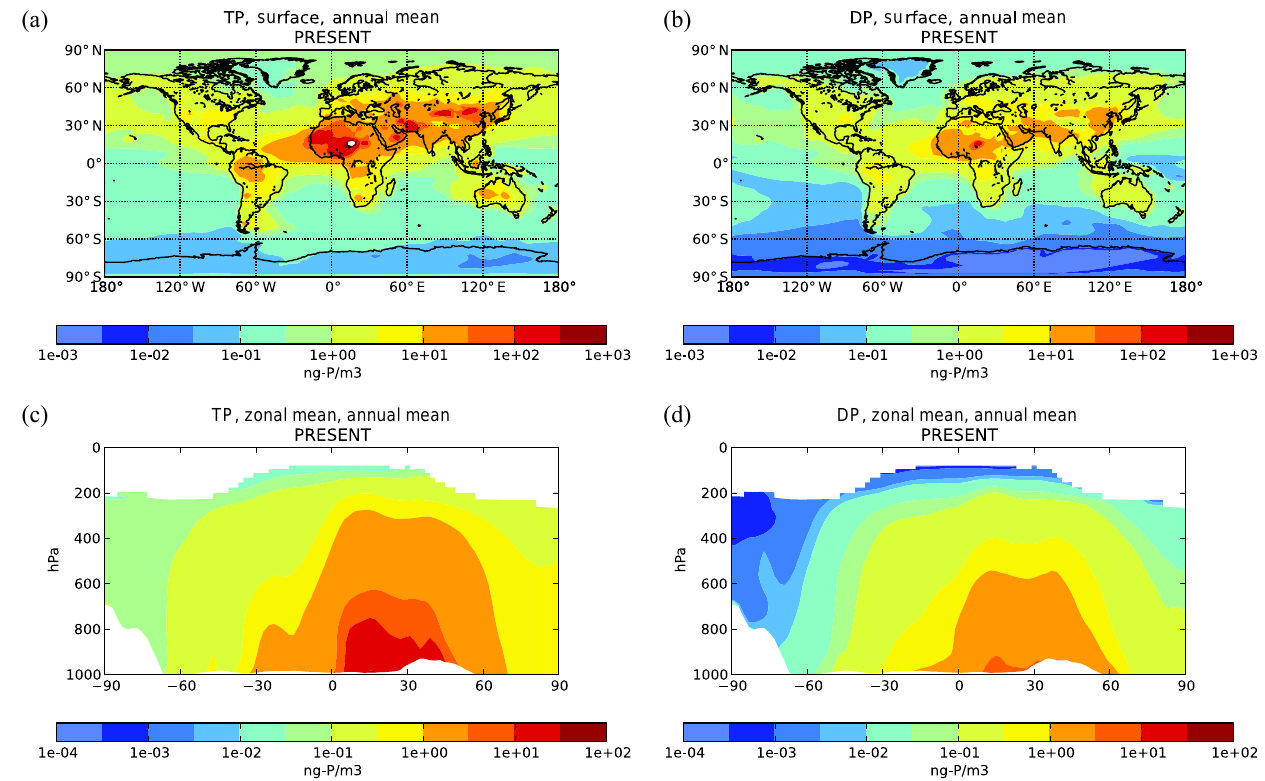
Figure 5. Annual mean concentrations (in ng-Pm − 3 ) of TP ( a , c ) and DP ( b , d ) for the surface ( a , b ) and in the troposphere as zonal mean ( c , d ), as calculated by the TM4-ECPL model for the present atmosphere (year